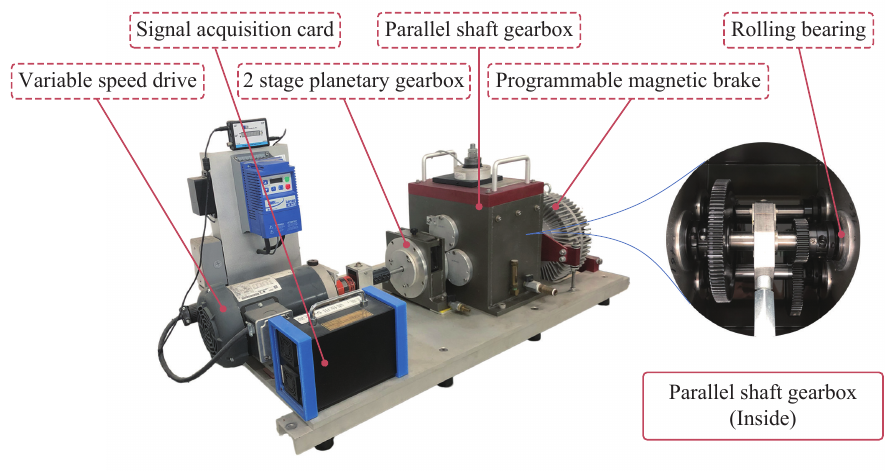
Figure 3. Drivetrain diagnostics simulator.